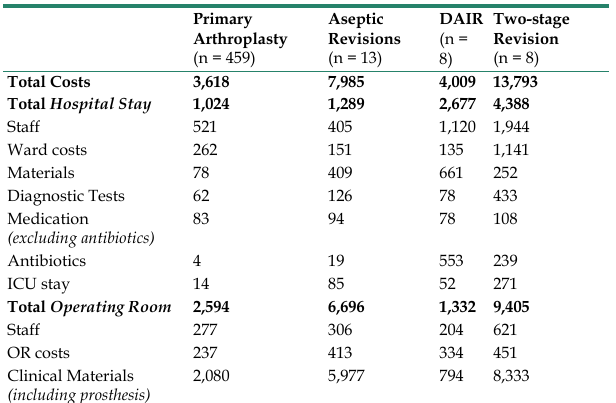
Table 3. Economic Data on 488 TKA cases (average cost